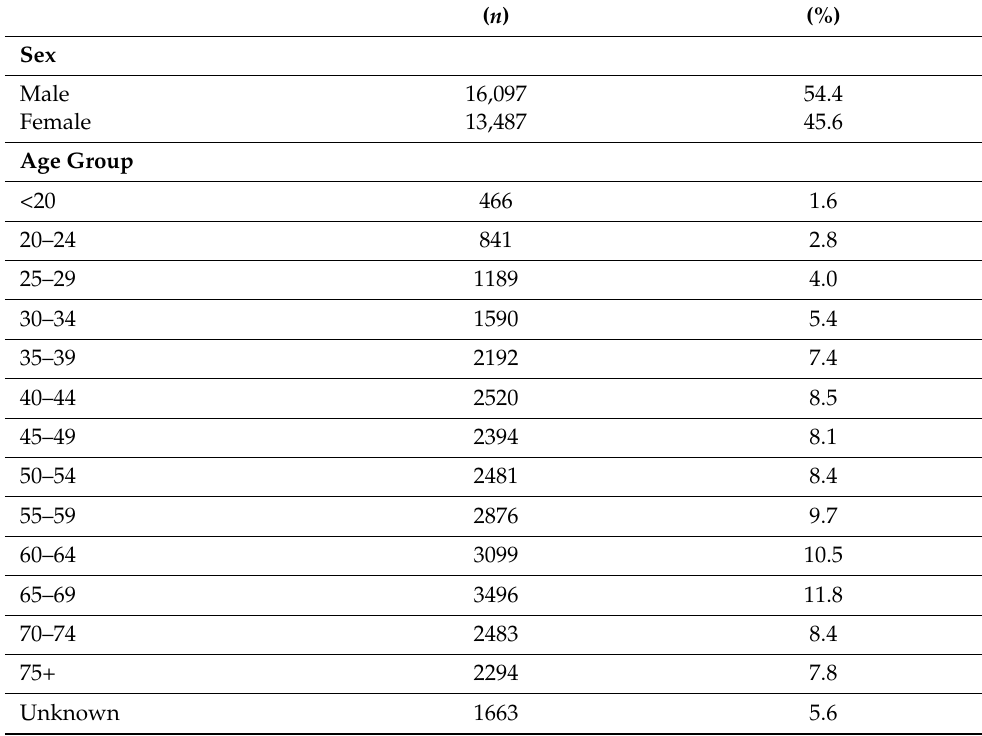
Table 1. Distribution of baseline characteristics of the participants.